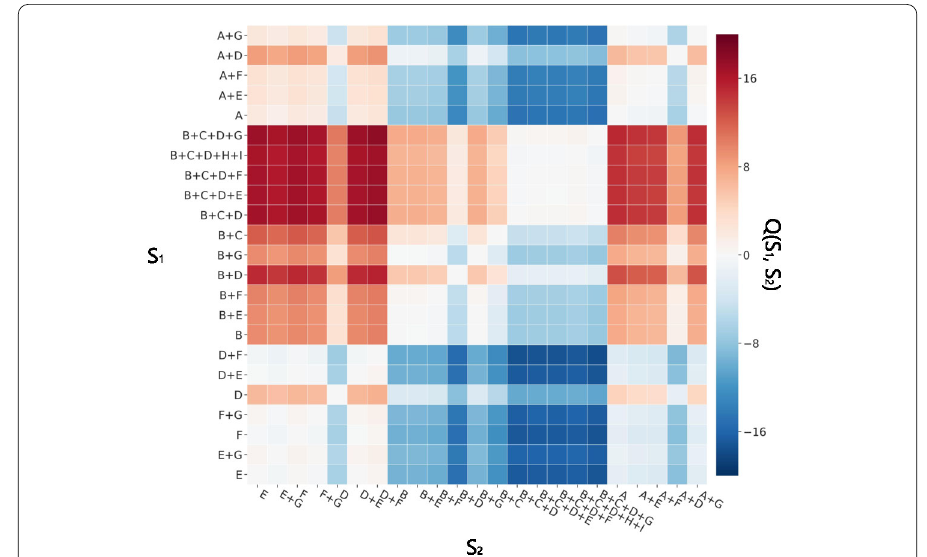
Figure 3 Comparison matrix of data representations using predictive accuracy. Each row/column corresponds to a specific data representation S . We label them according to the information we are using to define the set of contexts: A = player’s decision at t – 1, B = market evolution at t – 1, C = outcome of decision at t – 1, D = expert consultation, E = indications consulted, F/G = average over the 5 last/all rounds, H/I = market’s evolution/outcome before the previous round. Each matrix element Q S corresponds to the 1 S 2 average log ratio of predictive accuracies (see text) between representations S 1 , S 2 and is colored following the colorbar on the right hand side. Note that if Q S > 1 (red), S 1 (row) has a larger predictive accuracy than 1 S 2 < 1 (blue), S 1 (row) has a lower predictive accuracy than S 2 S 2 (column). If Q S 1 S 2